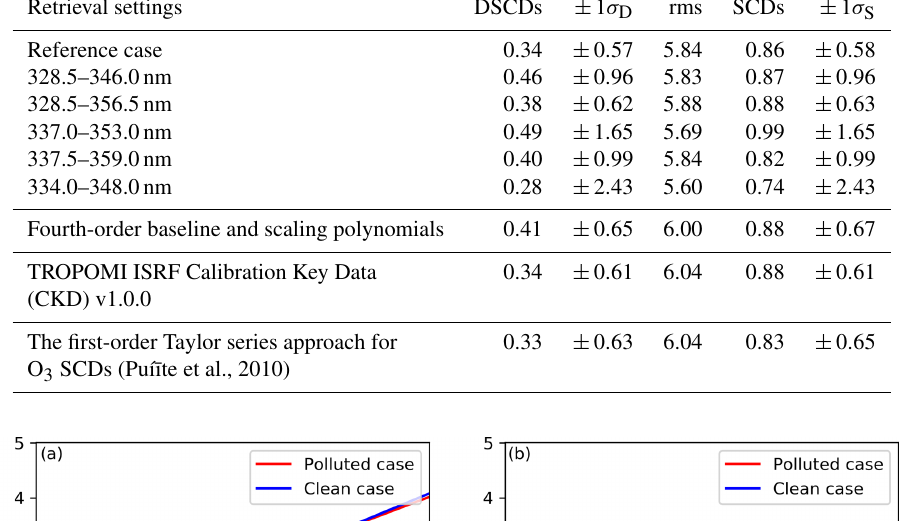
Table 3. Parameter effects on daily mean HCHO DSCDs and SCDs, ± 1 standard deviation of DSCDs ( ± 1 σ D ) and SCDs ( ± 1 σ S ) and mean root mean square (rms) of spectral fitting residual on 6 August 2018 of the region between 73 and 130 ◦ E and 18 and 54 ◦ N. Units of DSCDs, SCDs, ± 1 σ D and ± 1 σ S are × 10 16 moleccm − 2 . The rms units are × 10 − 4 . The detailed retrieval settings for the reference case are listed in the column with the header “Our retrieval” in Table 1. The rows below “Reference case” with specific settings are modified with respect to the reference case, while all other settings are kept unchanged.